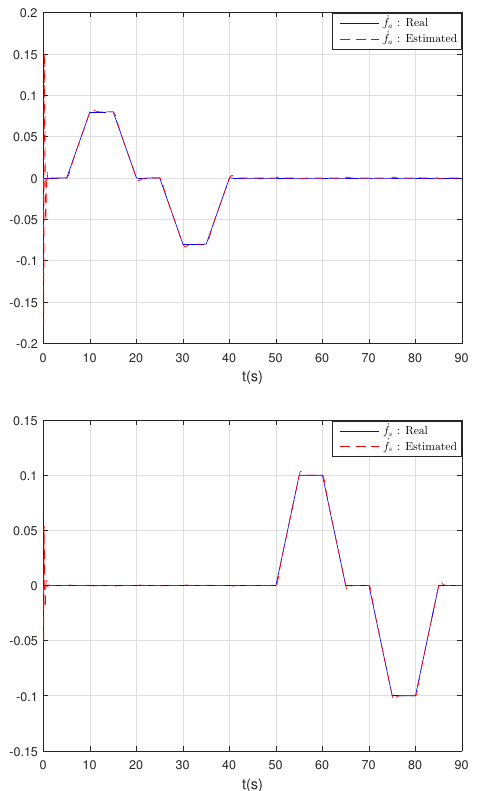
Figure 5. ˙ f a and ˙ f s with their estimates.